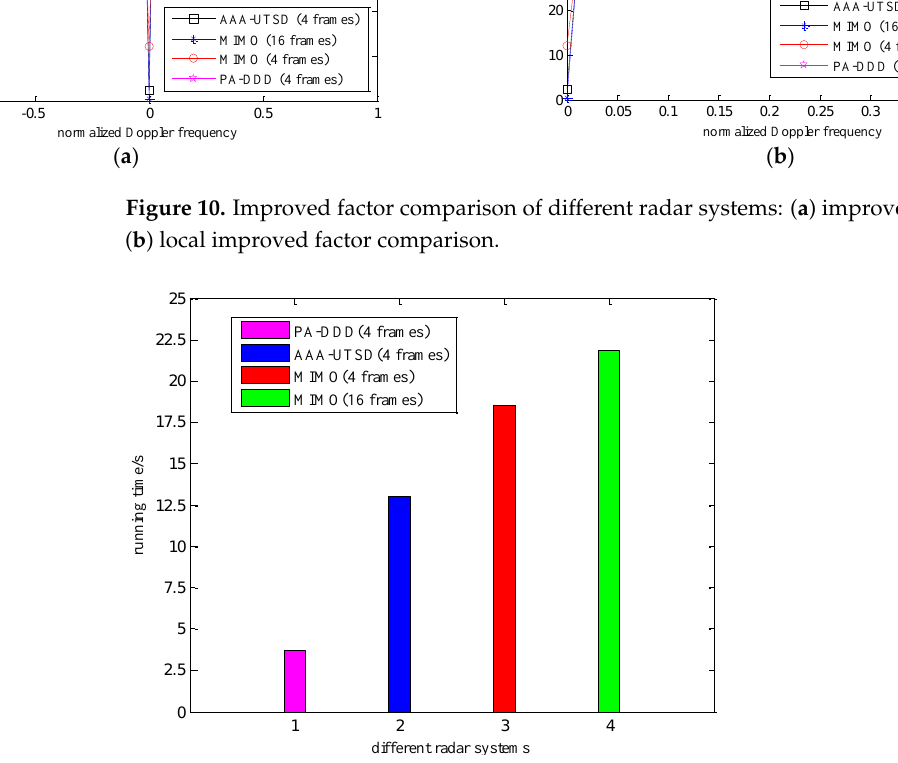
Figure 11. Running time comparison of different radar systems.